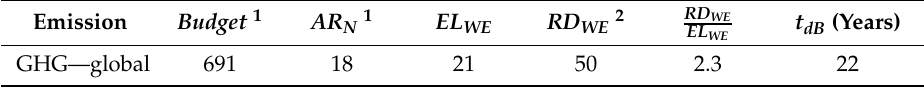
Table 2. Environmental sustainability assessment of global greenhouse gas (GHG) emissions